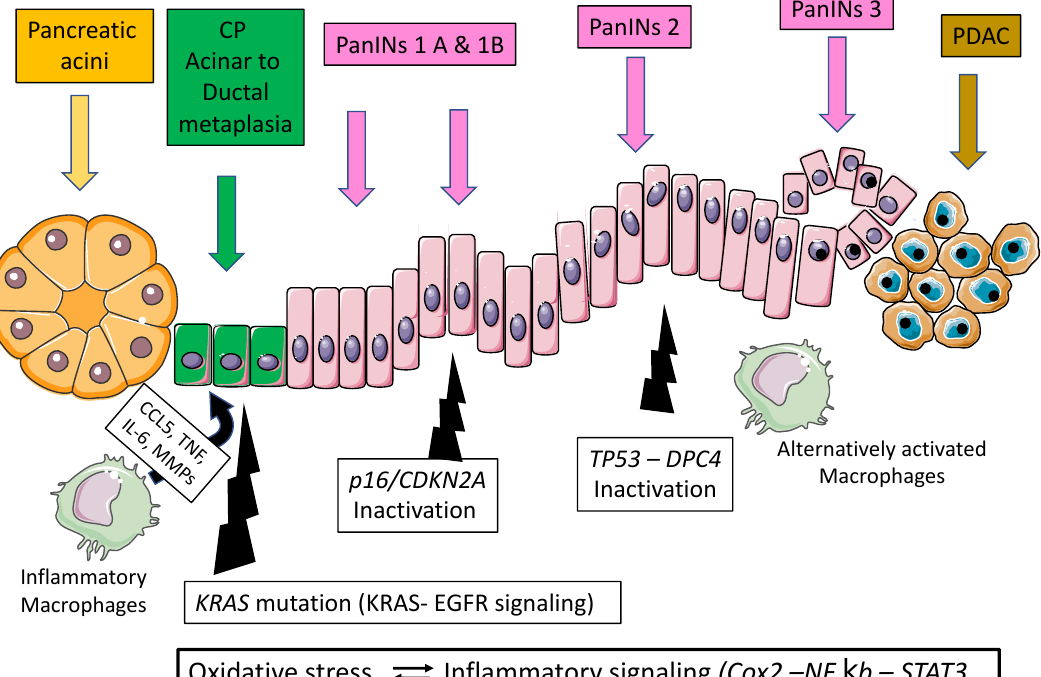
Figure 1. Natural history of pancreatic carcinogenesis in the specific context of inflammation. During acute pancreatitis, there are also other processes related to the phenomenon of pyroptosis with activation of the NLRP3 inflammasome and it’s signaling pathway. This pathway includes the activation of caspase-1, IL1- β and IL-18 [21,22]. Experimental evidence shows that adult mice that endogenously express oncogenic mutated KRAS in the acinar cell develop PanIN and PDAC lesions with higher penetrance when subjected to acute or chronic inflammation induced by cerulein. [20]. Sporadic episodes of pancreatitis (e.g., one month) are sufficient to induce PDAC in these mice. Longer inflammatory episodes (three months) or the induction of chronic pancreatitis, increase the incidence of tumors and reduce the latency of onset [18,21,22,26] (Figure 2). Even more importantly, adult mice can develop PDAC after induction of mutated KRAS in epithelial cells only following treatment with cerulein [23]. Molecular